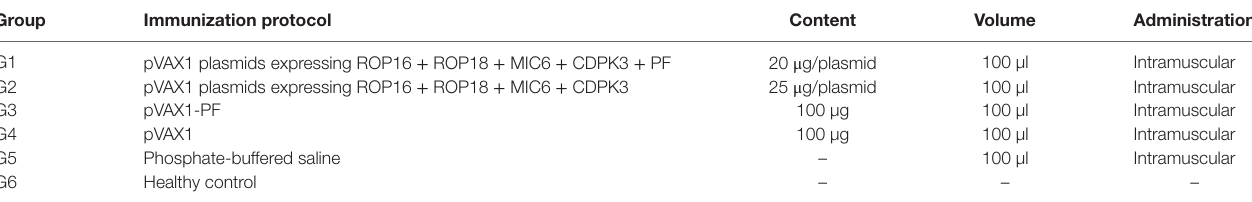
TaBle 1 | Vaccination regimens used in this study.